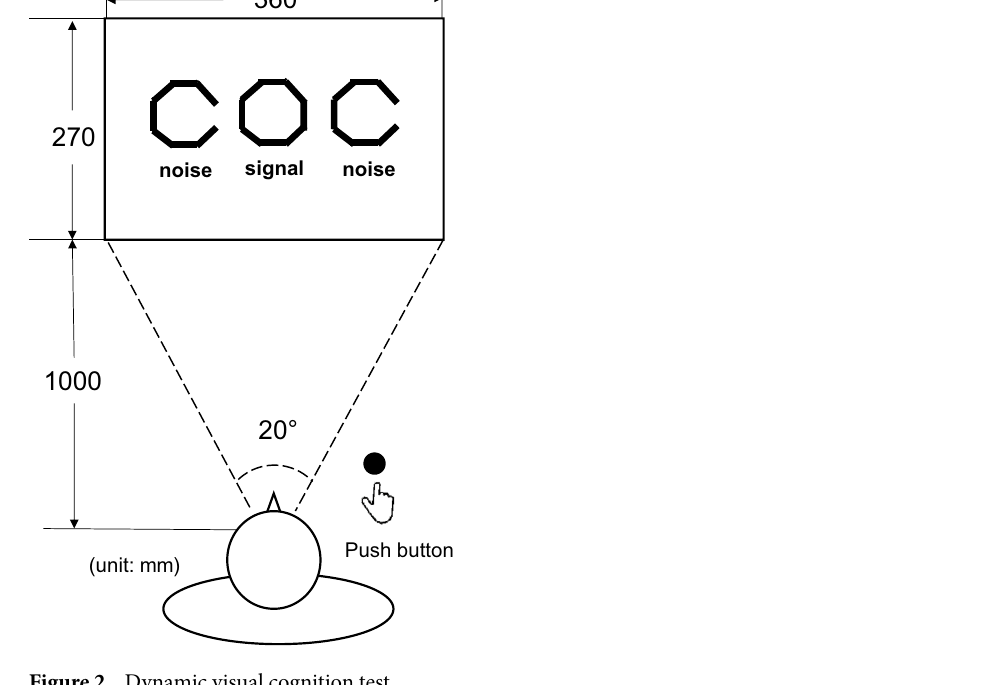
Figure 2. Dynamic visual cognition